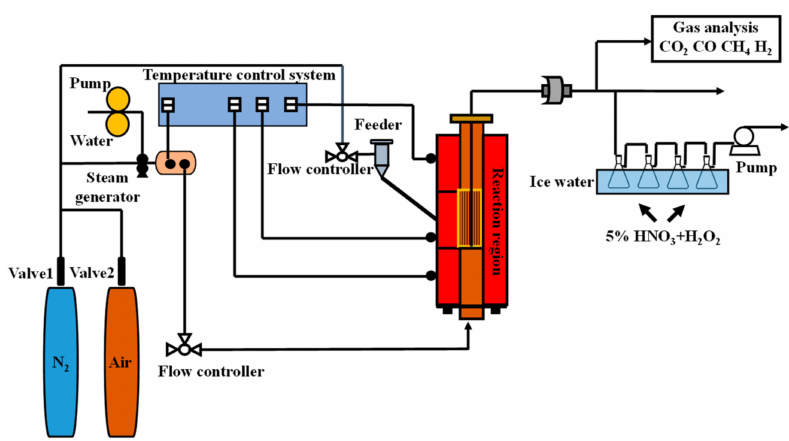
Figure 1. Schematic diagram of the laboratory